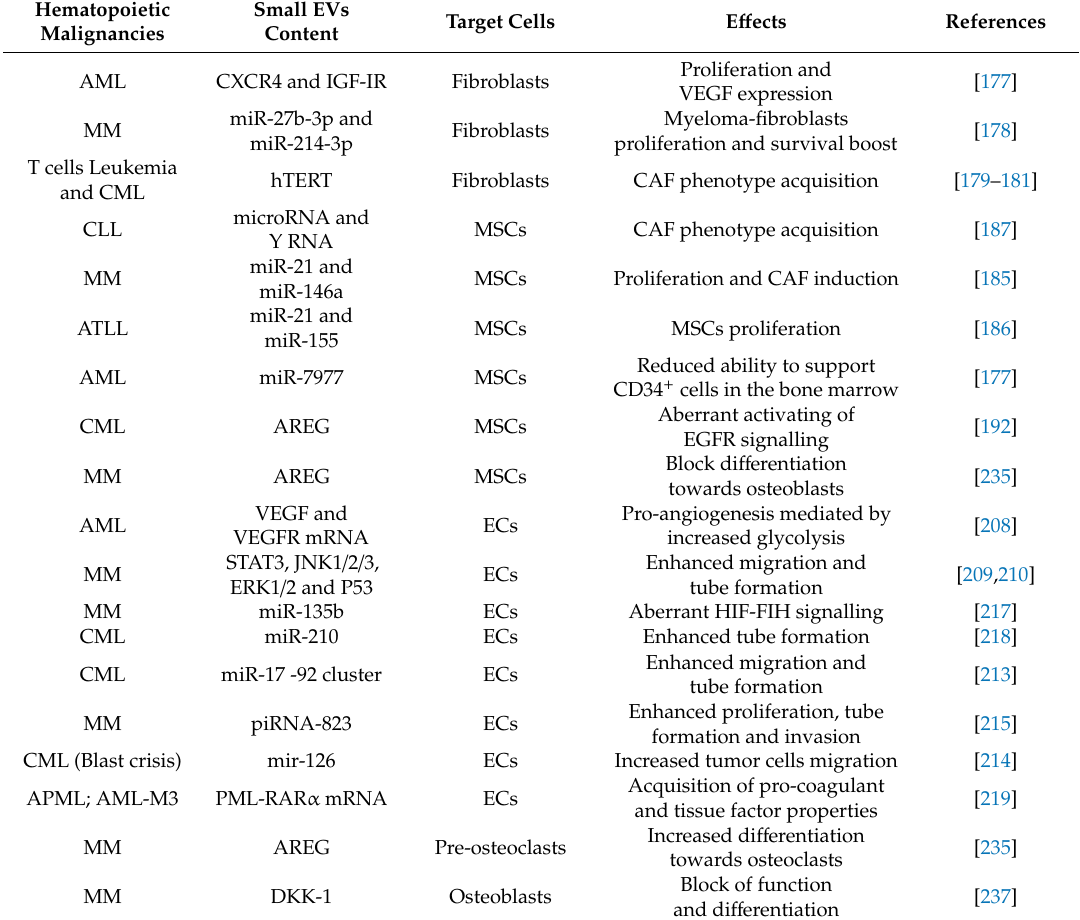
Table 2. Overview of the hematological malignancy-derived small EV functions based on the content and stromal cell